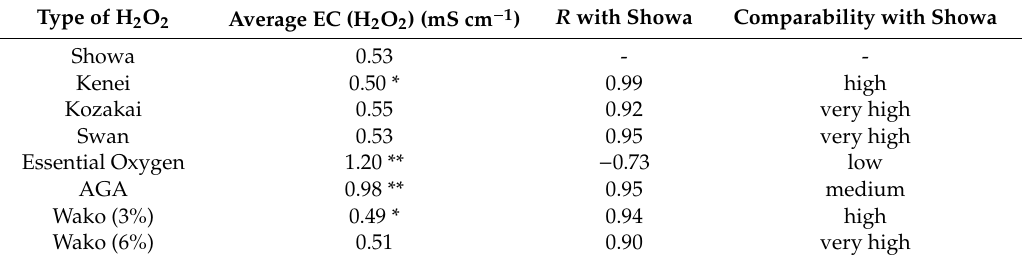
Table 6. Comparability of EC (H 2 O 2 ) values obtained by using different H 2 O 2 solutions.